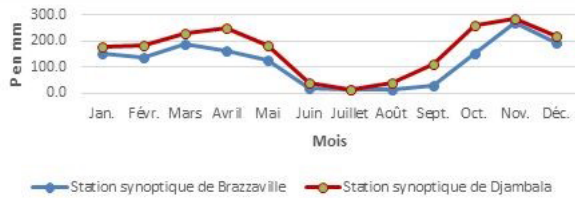
Figure 2. Variation des précipitations moyennes mensuelles sur les stations de Brazzaville et Djambala pour la période (1987–2018), source ANAC de